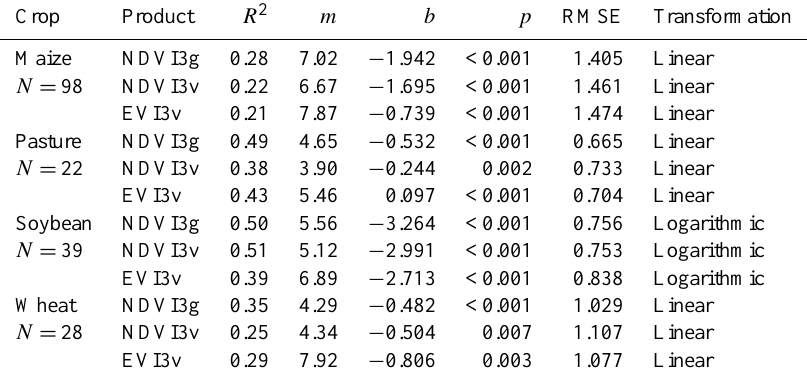
Table 2. Summary statistics ( R 2 is coefficient of determination, m is slope, b is intercept, p is significance, and RMSE is root mean square error) of the relationships between in situ leaf area index (LAI) and fraction of photosynthetically active radiation intercepted by the canopy ( F PAR ) estimated by the downscaled long-term vegetation records (NDVI3g is Global Inventory Modeling and Mapping Studies normalized difference vegetation index version 3, NDVI3v is Vegetation Index and Phenology Lab version 3 normalized difference vegetation index, and EVI3v is Vegetation Index and Phenology Lab enhanced vegetation index 2). A logarithmic transformation was performed for soybean to meet the assumptions of normality, while the in situ LAI from the other crops were not